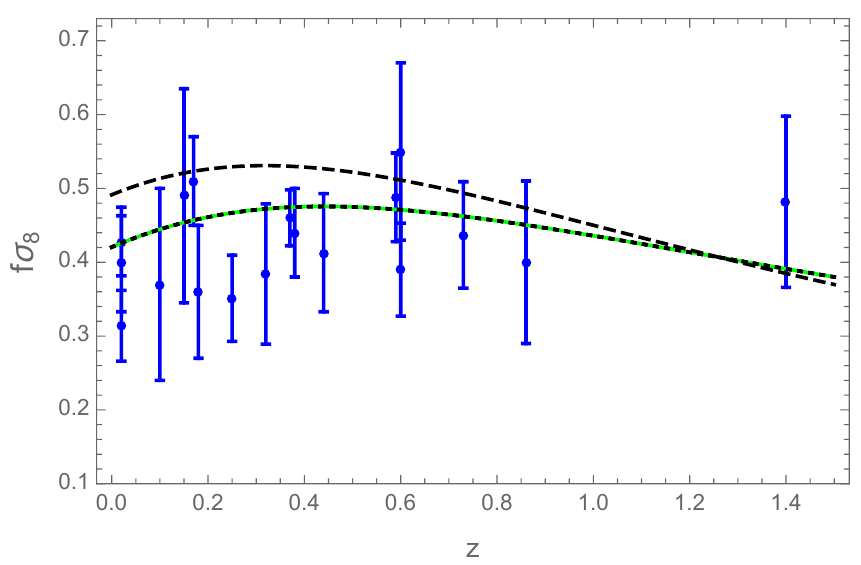
Figure 6 . The evolution of fσ 8 for the model (3.5). The different curves are calculated for the mode k = 300 a 0 H 0 , taking Ω m 0 = 0 . 30 . The dashed line corresponds to η = 3 and α = 10 , and the Λ CDM corresponds to the green line. The remaining curves, that correspond to η = 4 , 5 , 6 and respectively α = 10 2 , 10 4 , 10 6 , are indistinguishable form the Λ CDM model. Therefore for η ≥ 4 the model aligns with the cosmological constant and does not relax the fσ 8